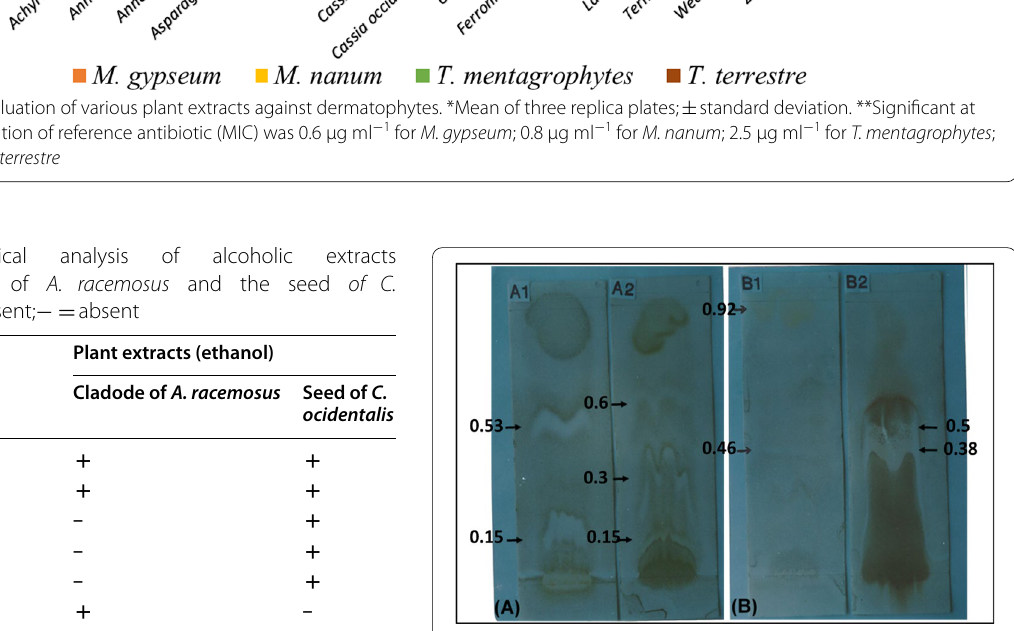
Fig. 2 Detection of antifungal compounds in cladode extract of A. racemosus . ( a ) and in seed extract of C. occidentalis ( b ) by